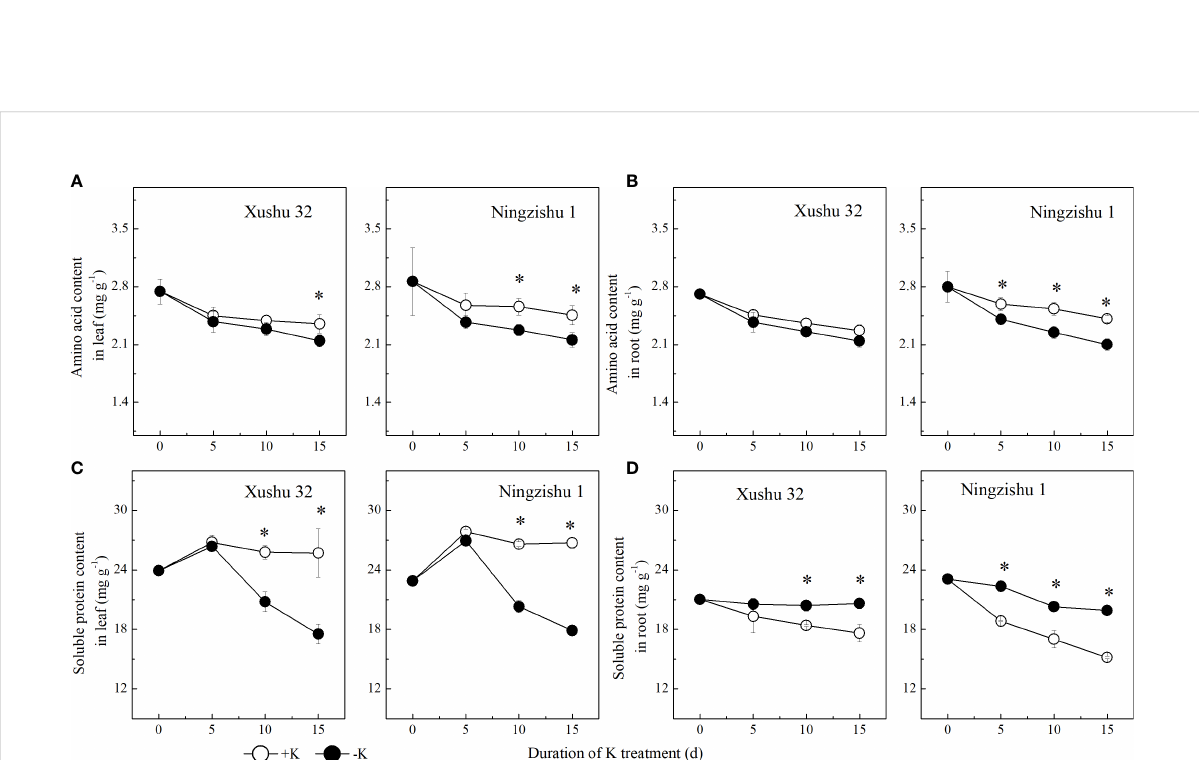
FIGURE 4 Changes of amino acid and soluble protein content in leaves and roots for two K treatments for Xushu 32 and Ningzishu 1. (A, B) leaf and root amino acid contents. (C, D) Leaf and root soluble protein contents. The stages labeled with an asterisk (*) indicate signi fi cant differences ( p < 0.05) between − K and +K.